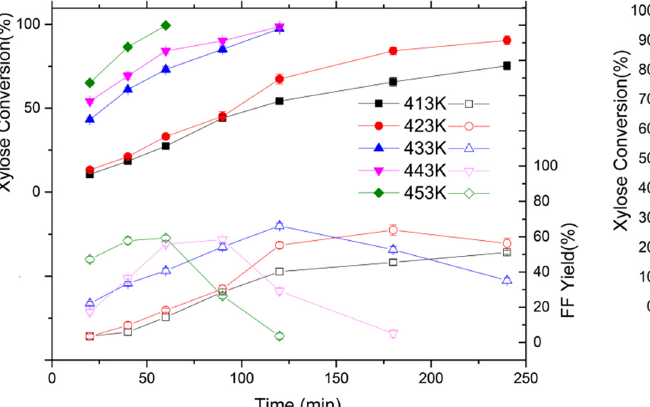
Figure 9: E ff ect of water content on the conversion from xylose to FF. Reaction conditions: 433 K, 150 mg G/F - 1/4, 5 mL solvent, 750 mg